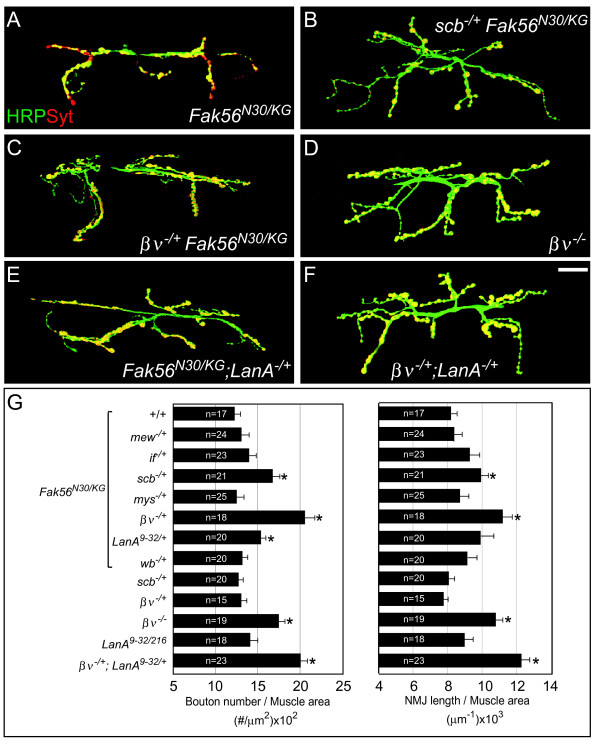
Genetic interactions between Fak56 and integrin signaling pathway components during neuromuscular junction (NMJ) growth. (A-F) Images of NMJ 6/7 are shown as described for Figure 1C, D. Hypomorphic Fak56N30/KG mutants showed a normal morphology (A), but one allele of scb2 (B), βν1 (C) or LanA9–32 (E) in Fak56N30/KG induced dramatic NMJ growth. Overelaborated NMJs in transheterozygotes βν1/2 (D) and βν1/+;LanA9–32/+ (F) mutants are shown. (G) Quantification of NMJ 6/7 phenotypes for Fak56N30/KG, mew1/+;Fak56N30/KG, ifk27e/+;Fak56N30/KG, scb2/+ Fak56N30/KG, mys1/+;Fak56N30/KG, βν1/+Fak56N30/KG, Fak56N30/KG;LanA9–32/+, wb4Y18/+ Fak56N30/KG, scb2/+, βν1/+, βν1/2, LanA9–32/216 and βν1/+;LanA9–32/+. Asterisks indicate significant difference by Student's t test (p < 0.05) and error bars represent the standard error of the mean (SEM).